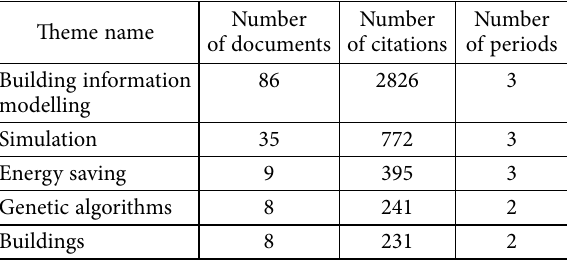
Table 11. Performance measures of detected thematic areas Theme